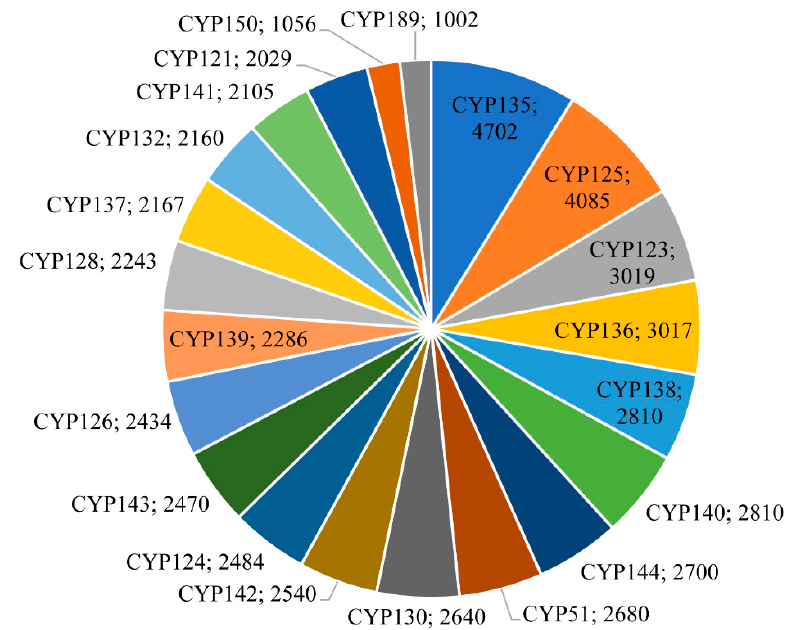
Figure 1. Comparative analysis of P450 families in 2666 mycobacterial species. P450 families with >1000 members were presented in the figure. The P450 family name and number of P450s are shown